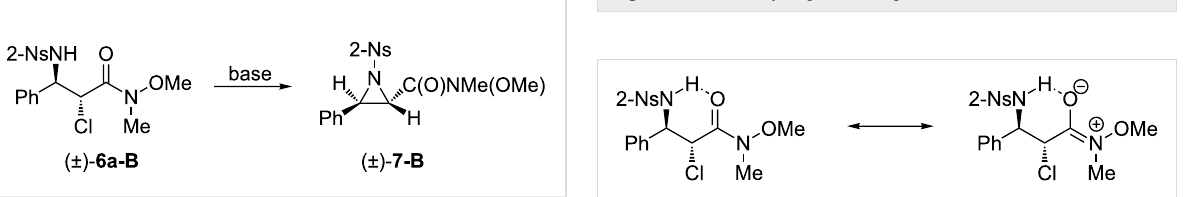
Figure 1: Possible hydrogen bonding conformation.